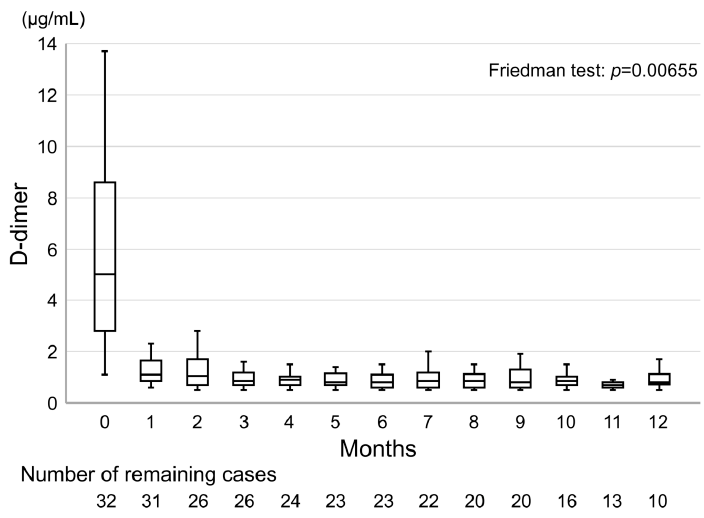
Figure 6. Kaplan–Meier cumulative-event rates for major bleeding.